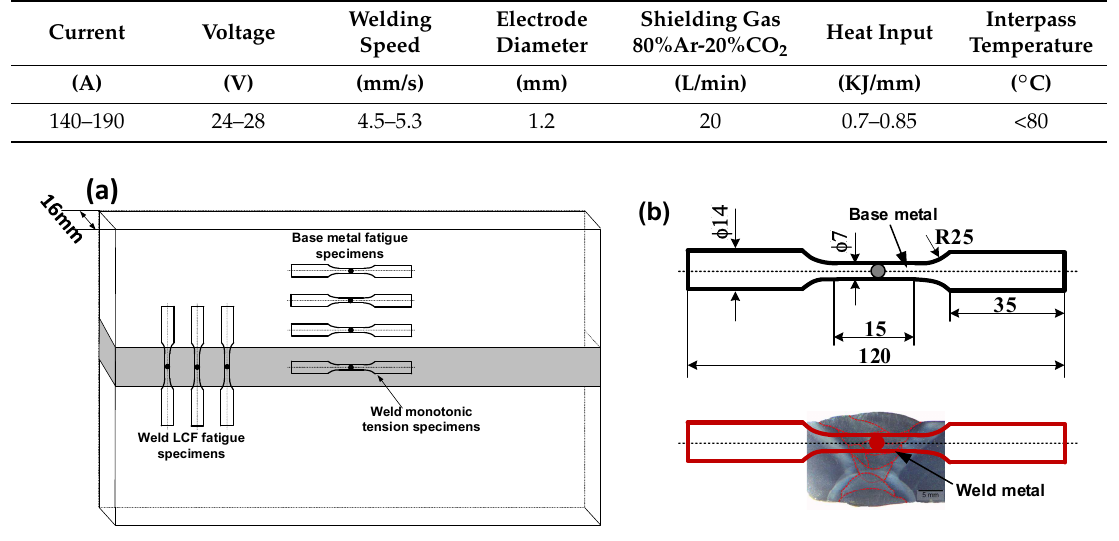
Figure 2. ( a ) Orientation of monotonic tension and fatigue test specimens with respect to the welded joints; ( b ) Schematic of LCF test specimens about base metal and weld metal.